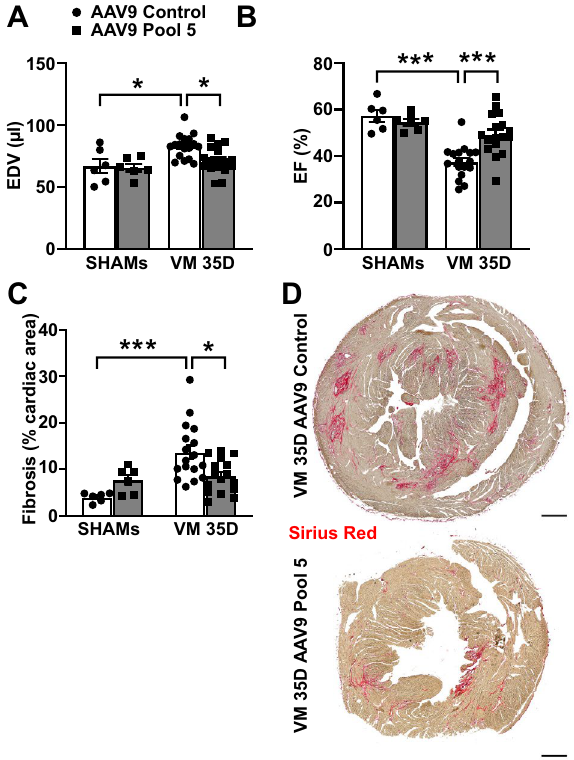
Figure 5. Overexpression of Pool 5 improves cardiac function in the chronic phase during VM. ( A ) End- diastolic volume (EDV) and ( B ) ejection fraction (EF) measured by echocardiography in infected Pool 5-overexpressing C3H mice and infected controls 35 days after CVB3 infection. Significance assessed by two-way ANOVA followed by Tukey’s test with *p ≤ 0.05, ***p ≤ 0.001. ( C , D ) Fibrosis detected by Sirius Red staining in infected Pool 5-overexpressing hearts and controls 35 days after CVB3 infection. Scale bar = 500 µm. Significance assessed by two-way ANOVA followed by Tukey’s test with *p ≤ 0.05; ***p ≤ 0.001. All values are expressed as mean ±